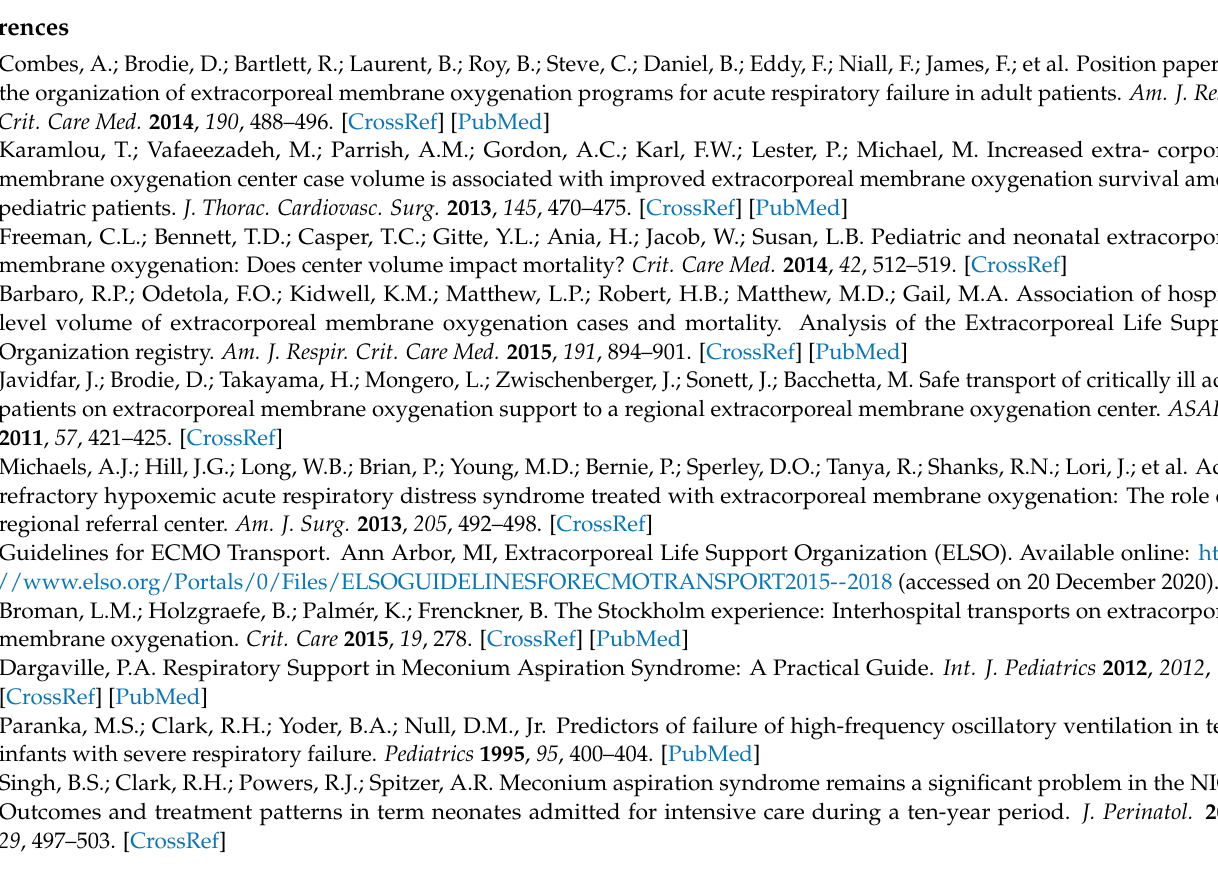
Table S4: Pediatric HandS ECMO data form (for the